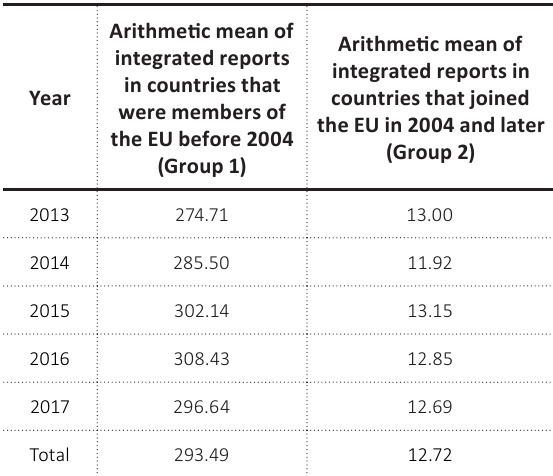
Source: Own research.